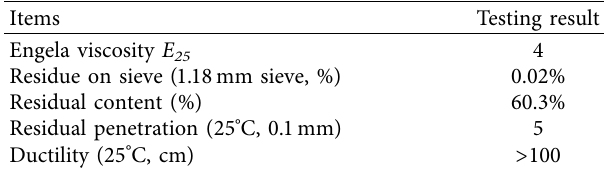
Table 3: Properties of PC-3 emulsified